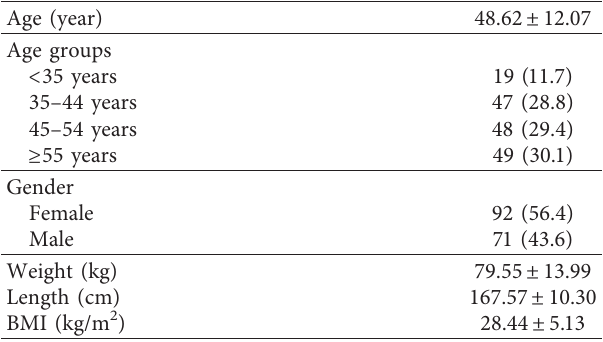
Table 1: Distribution of demographic characteristics of